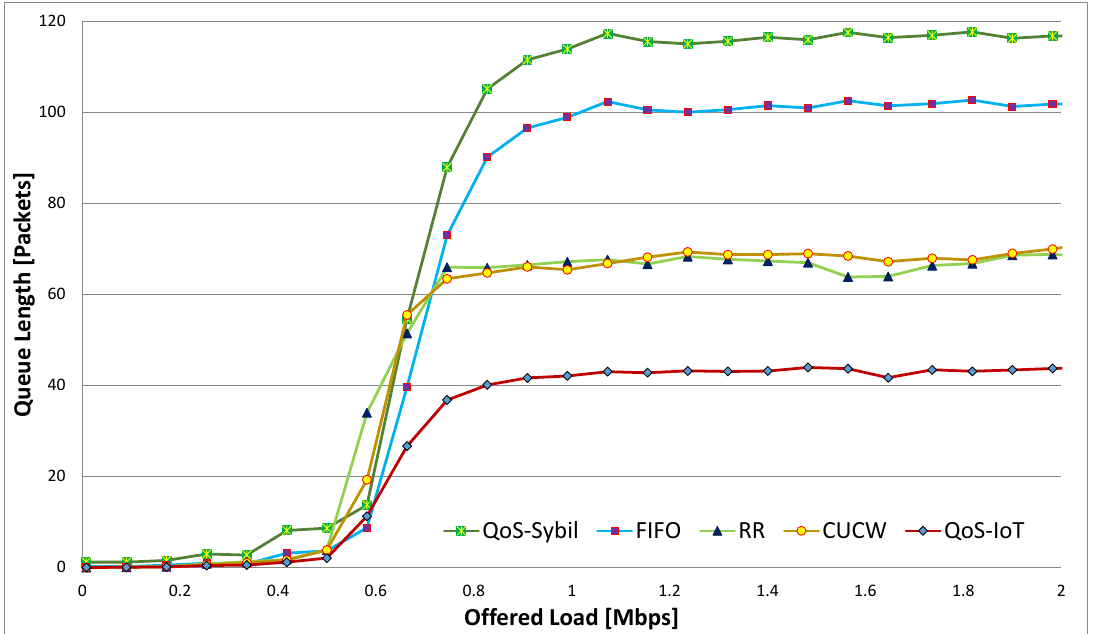
Figure 8. Average queue length in of all flows in the presence of Sybil